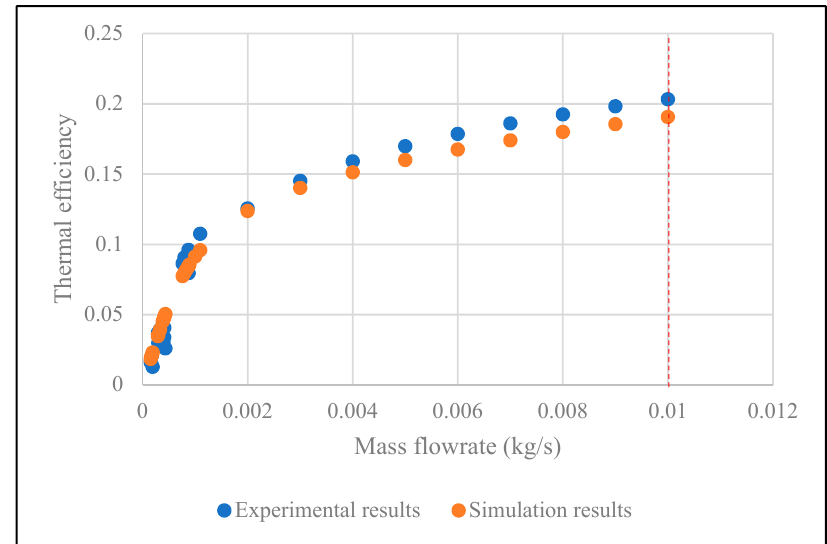
Figure 7. Comparison between the theoretical and experimental results on the effect of air mass flow rate to the thermal e ffi ciency at G = 800–900 Wm − 2 and T a , avg = 307.5 K.